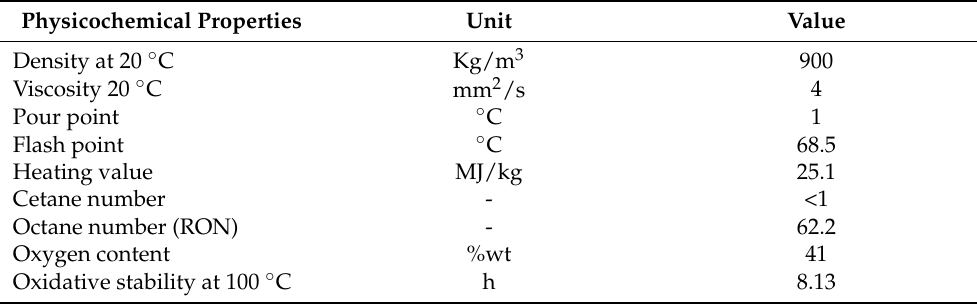
Table 3. The physicochemical properties of polymeric biodiesel (HBME) (adapted from [20,22,57]). Physicochemical Properties Unit Value Density at 20 ◦ C Kg/m